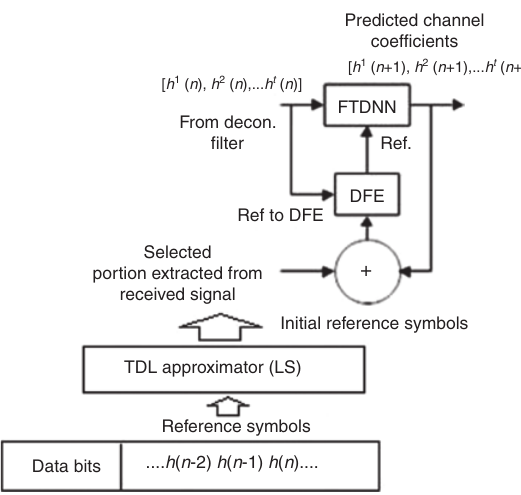
Figure 6: One Section of the Proposed Split FTDNN-DFE Block during